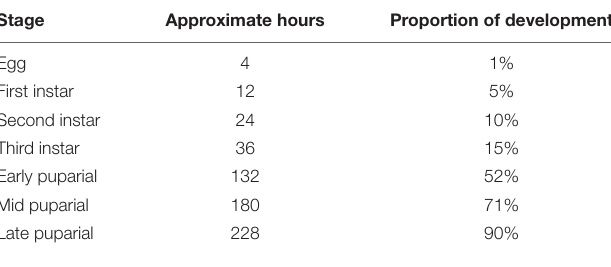
TABLE 2 | Hours of development and proportion of development completed for each sampling group for transcriptomic analysis throughout immature development in Chrysomya rufifacies reared at 30 ◦